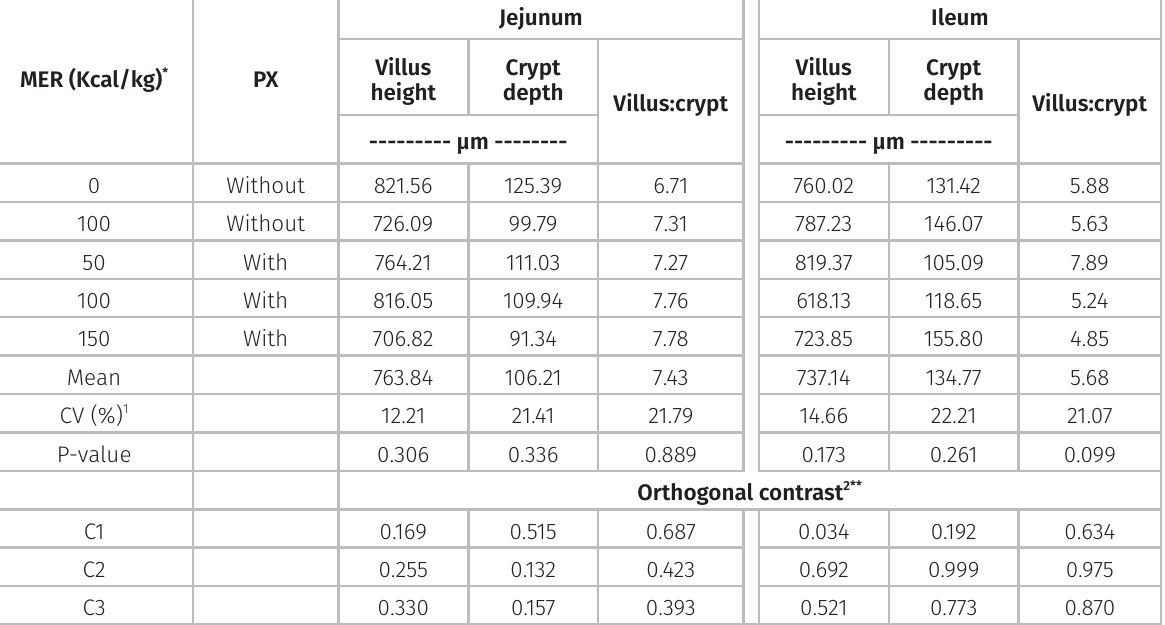
Table V. Intestinal morphometry of 21-day-old broilers fed diets with reductions in metabolizable energy (MER), P, Ca and Na and supplemented with phytase and xylanase